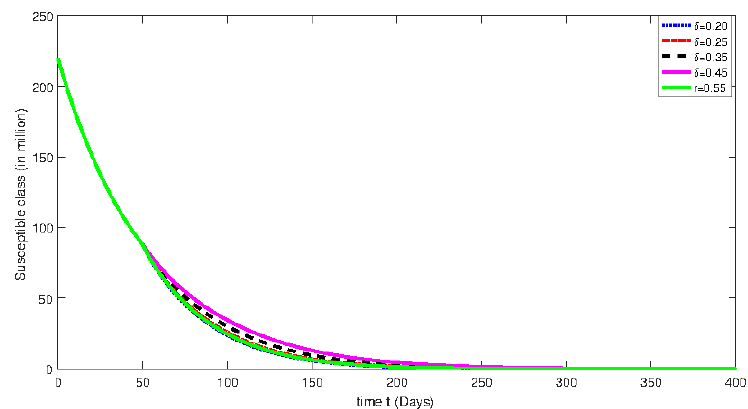
Figure 3. Numerical solution for susceptible class for the given days and using different fractional orders with isolation rate of 30%.